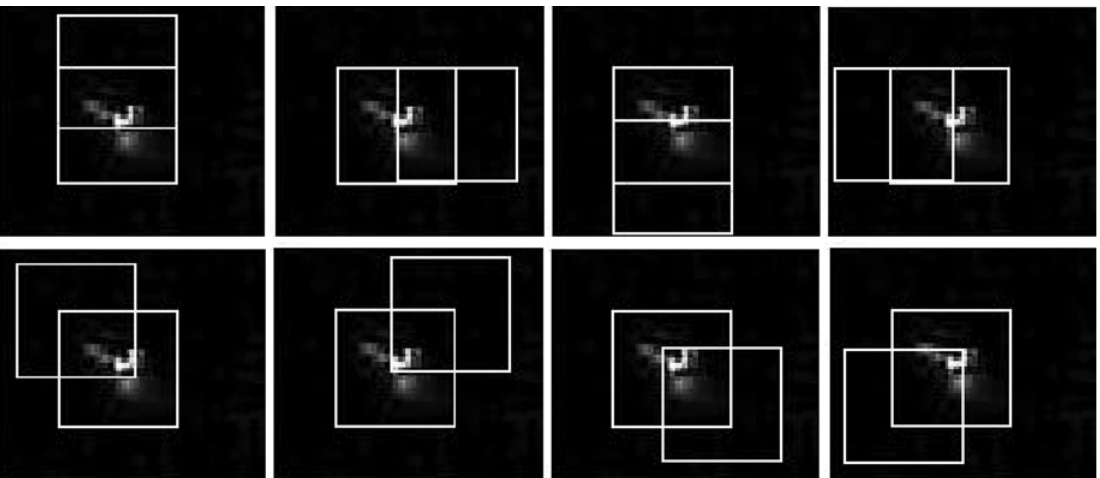
Figure 6: Selection of Fixed Size Target and Background Window for Texture